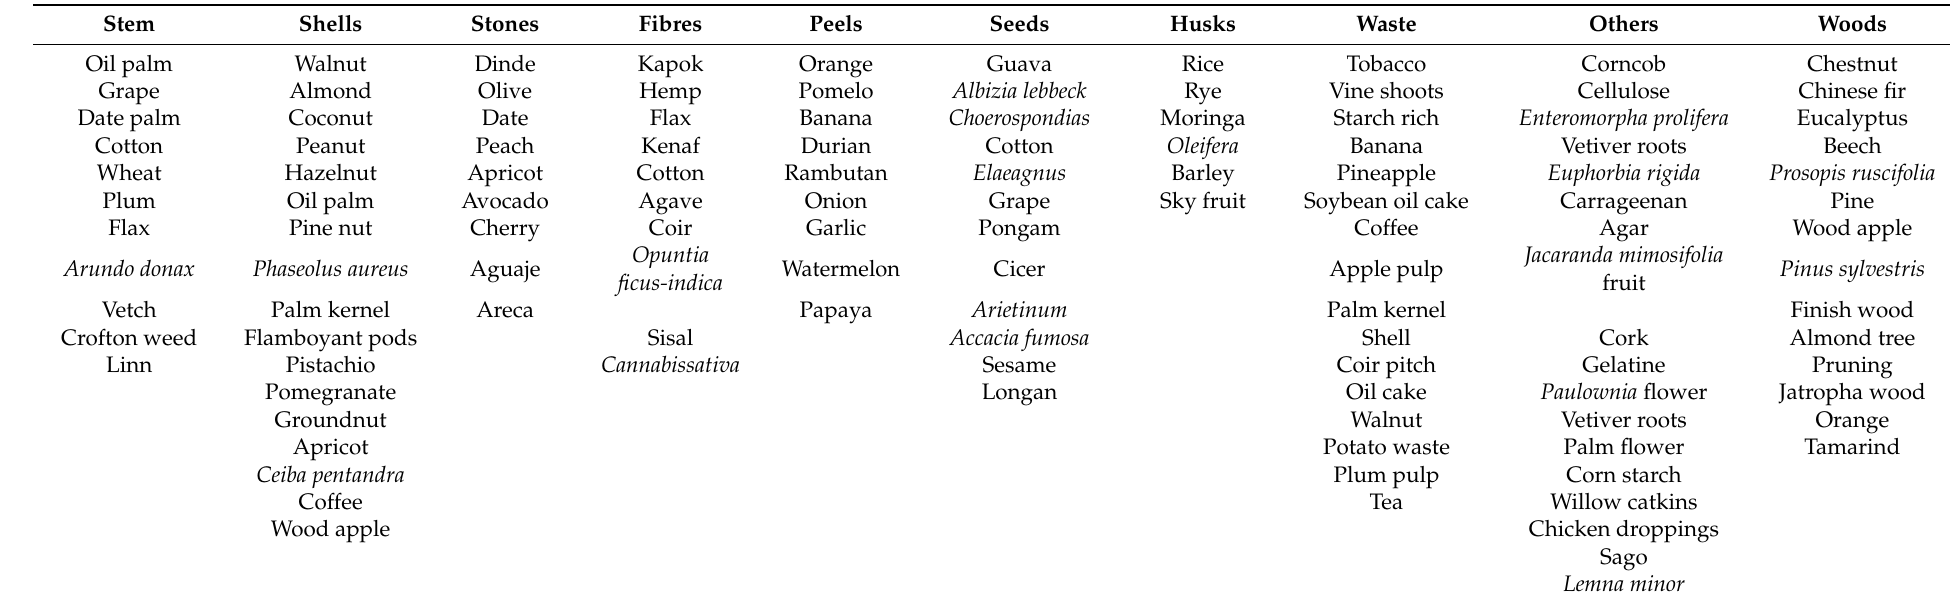
Table 1. Summary of lignocellulose precursors for the synthesis of activated carbon